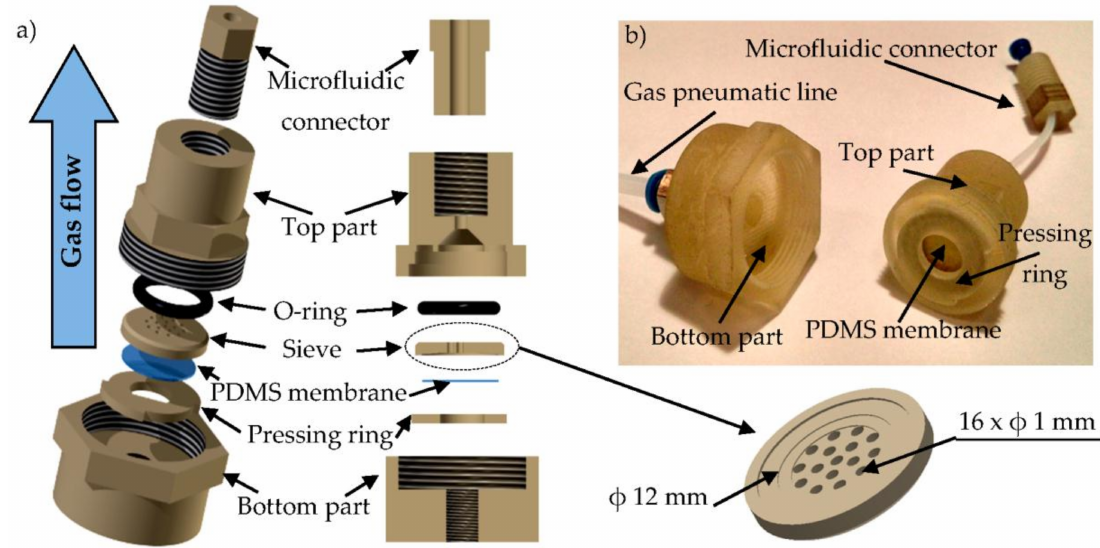
Figure 2. 3D printed membrane-based gas microflow regulator: ( a ) on the left, exploded schematic view; on the right, cross section with magnified view of the sieve; ( b ) bottom and top part of the regulator prior to